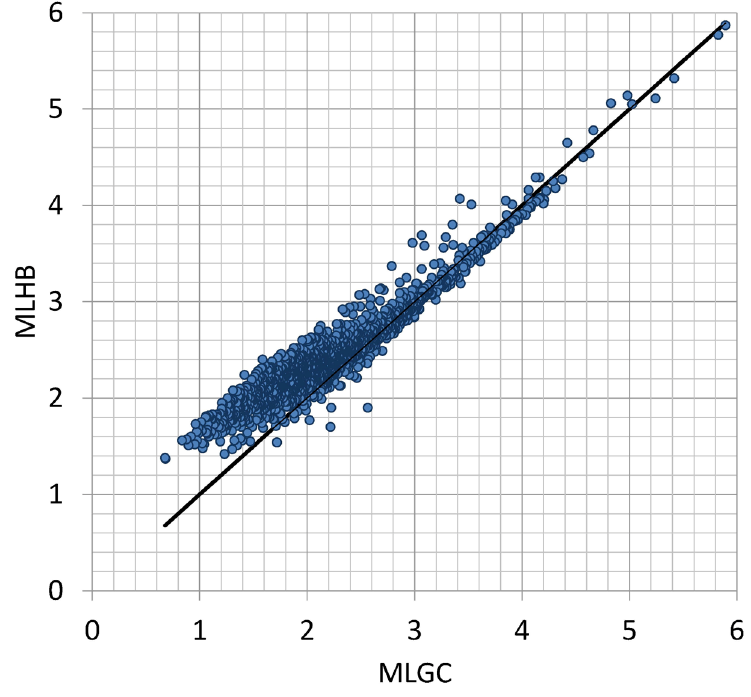
Figure 5. Hutton Boore magnitudes for the Emilia seismic sequence (MLHB) as a function of the same magnitudes computed with the Italian attenua- tion relation and station corrections (MLGC). There is a good correspondence of the values >M magnitudes of small events, as an average.